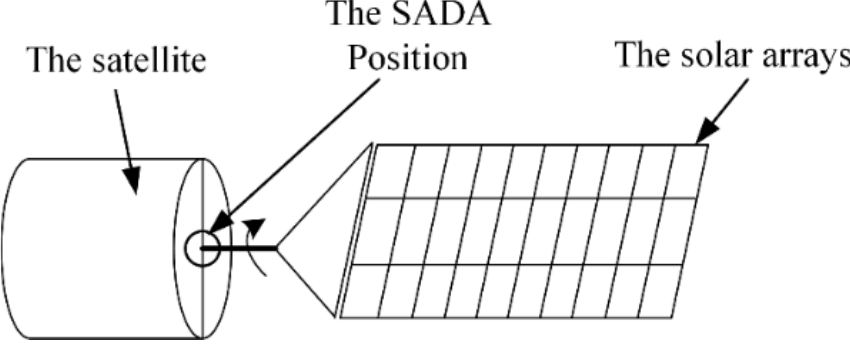
Figure 2. Schematic diagram of satellite system [3].